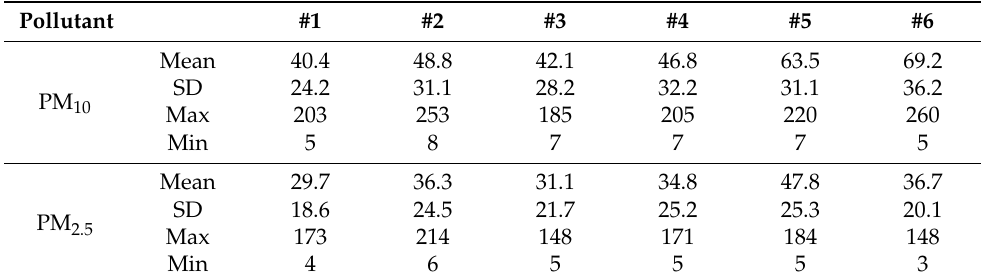
Table 2. Sensor specifications for indoor air quality